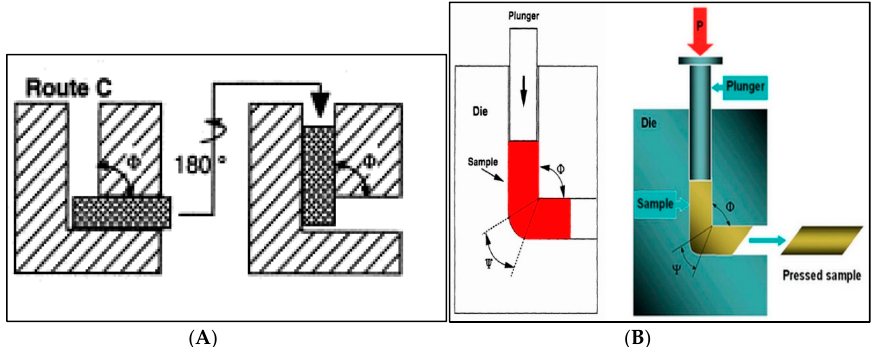
Figure 1. A schematic diagram of equal-channel angular pressing (ECAP) die: ( A ) route C path, ( B ) three-dimensional (3D) presentation of ECAP die.